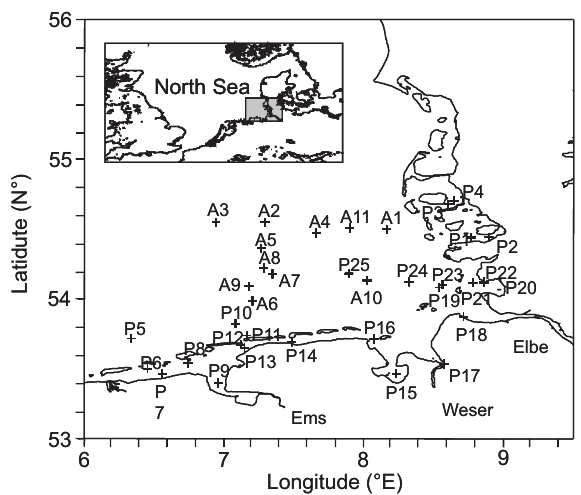
F IG . 1. – Map showing positions of Alkor (A) and Prandtl (P) sta- tions sampled in June/July 2005 and the position of the sampling area relative to the North Sea